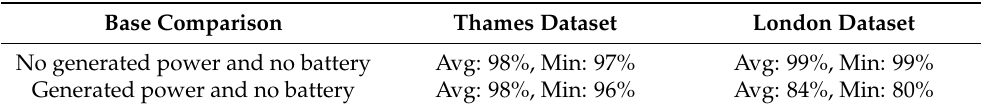
Table 4. Relative performance of the smart algorithm with linear generation and demand uncertainty compared to perfect forecasts in the simulated Thames or London environment. The underlying basis for comparison is no battery and/or generated power (Table